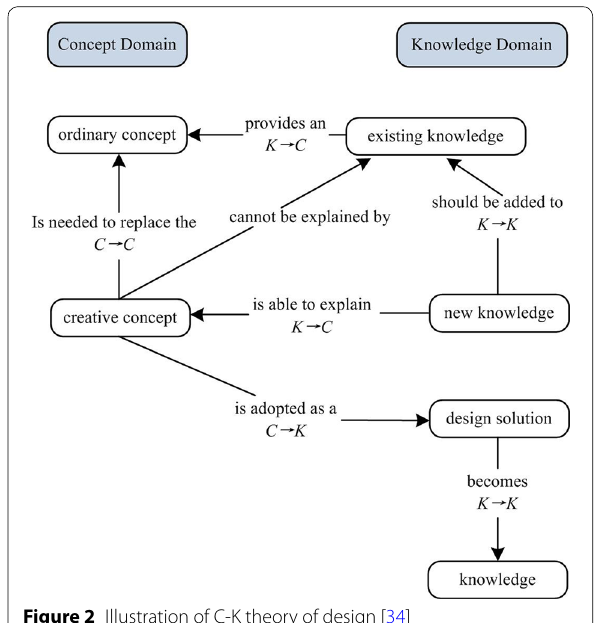
Figure 2 Illustration of C-K theory of design